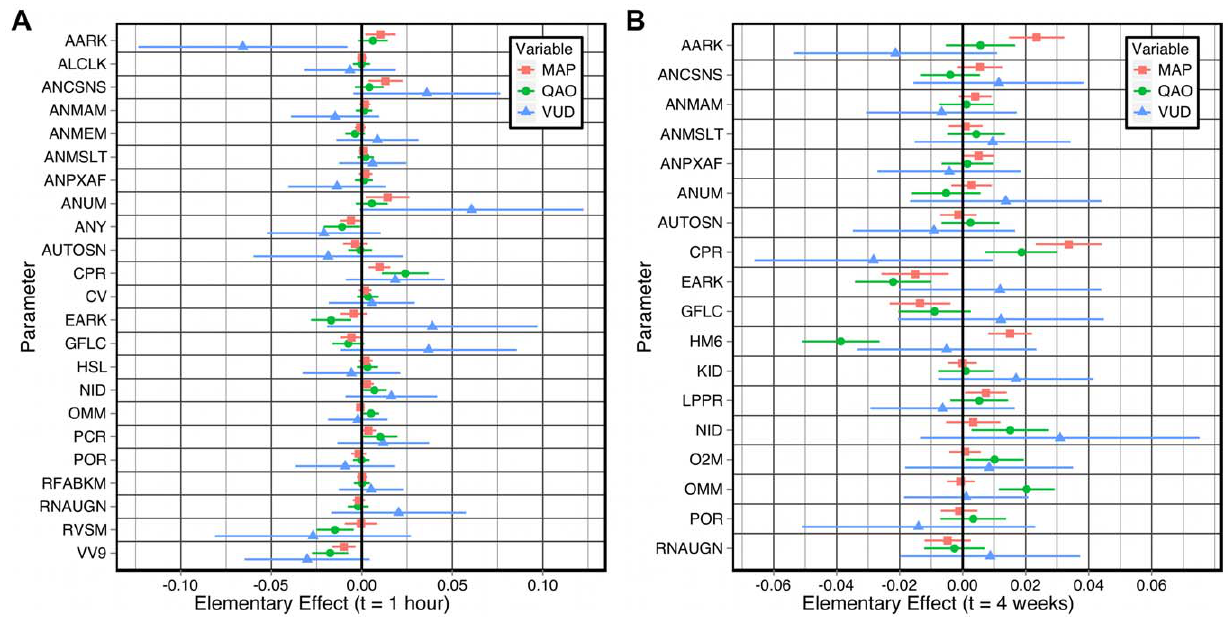
Figure 3. The largest elementary effects on three key output variables at t ~ 1 hour and t ~ 4 weeks . The effects on mean arterial pressure (MAP), cardiac output (QAO) and rate of urine production (VUD) are plotted as m + s . Elementary effects were sorted by the magnitude of their largest effect on the three output variables. A: The elementary effects at t ~ 1 hour (excluding HYL). B: The elementary effects at t ~ 4 weeks .